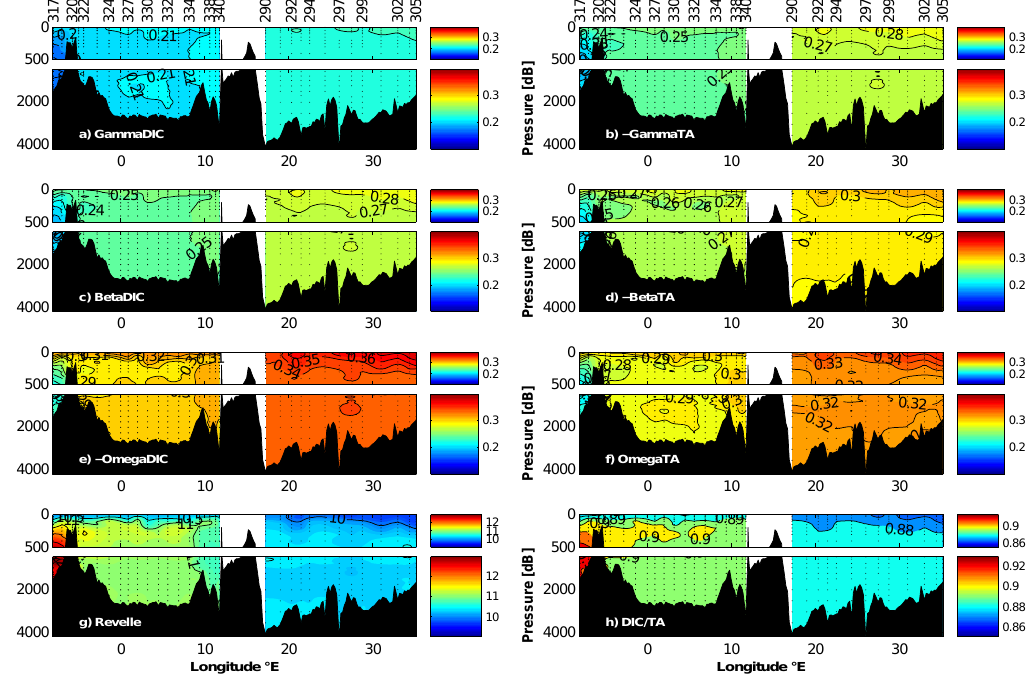
Fig. 10. Vertical distribution in the Mediterranean Sea from the Meteor cruise M84/3 of the buffer factors (a) γ DIC , (b) – γ TA , (c) β DIC , (d) – β TA , (e) – ω DIC , (f) ω TA , all in mmolkg − 1 , (g) Revelle factor and (h) DIC/TA ratio, both dimensionless. – By examining the Revelle factor it is obvious that